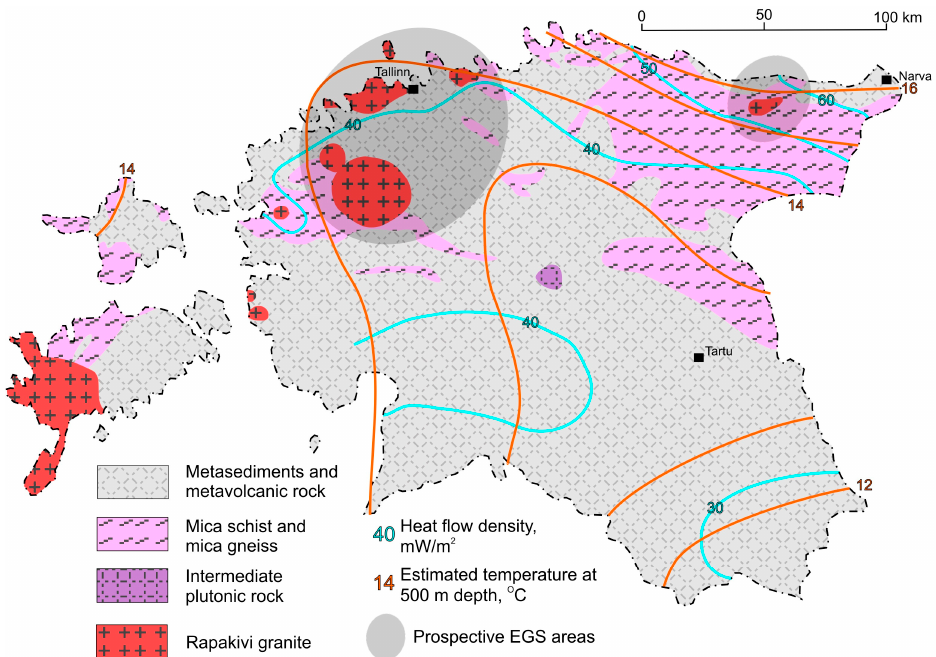
Figure 6. Elements of the Estonian crystalline basement, heat flow density and estimated temperature (based on [49,57] ).